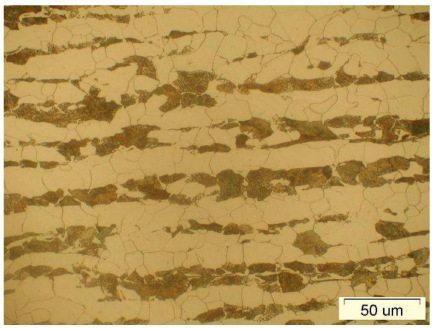
Figure 5. Steel structure base metal.